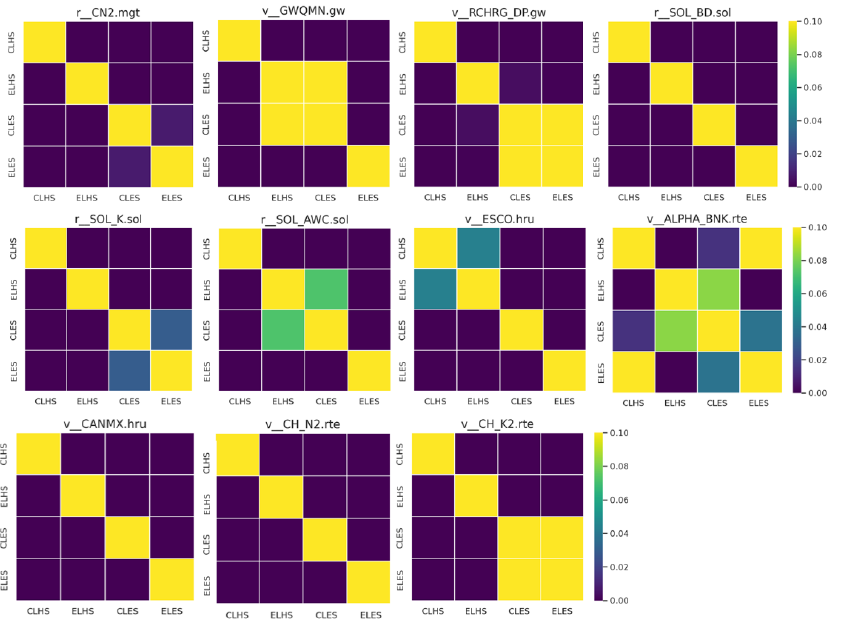
Figure A3. Crosswise comparison of model parameter ranges with the p -value of the Mann–Whitney- U test during initial